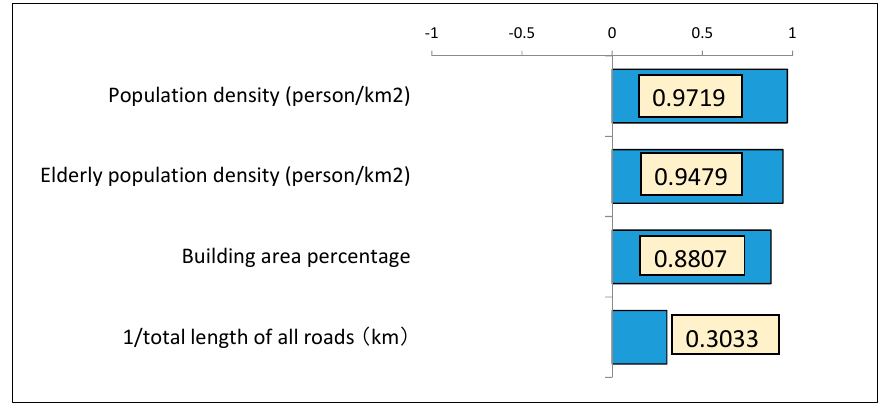
Table 3. Eigenvalues, contribution ratio, and cumulative contribution ratio of principal components 1 to 4. Primary Component